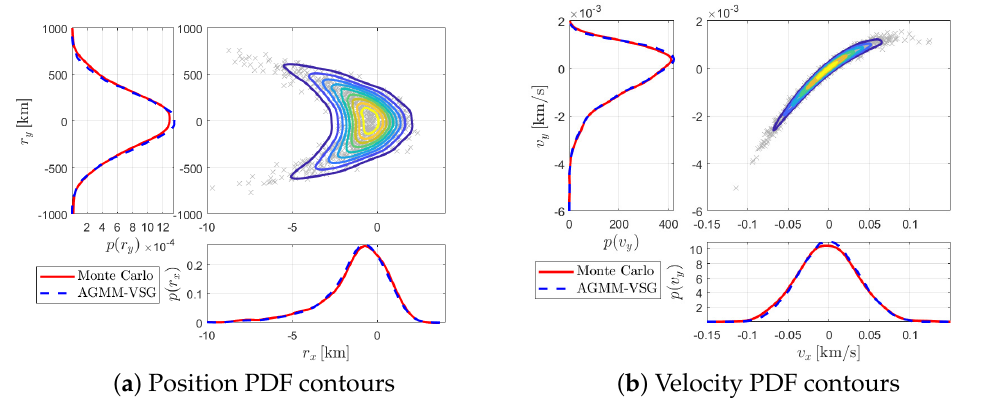
Figure 3. PDF contours using AGMM-VSG with Monte Carlo samples of HEO